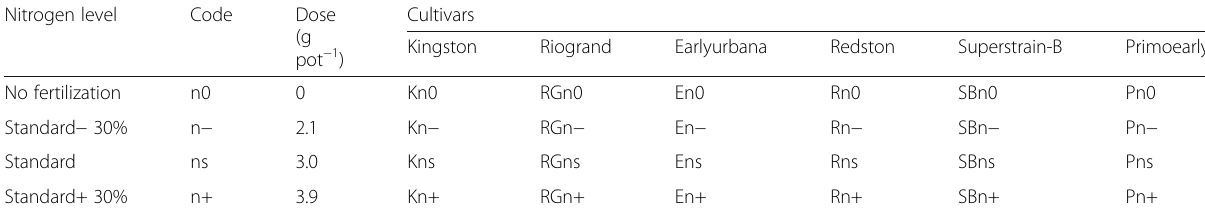
Table 2 Composition of nitrogen regimes and cultivars used in the experiments. Treatment abbreviations were presented for the ease of pronunciation and comparisons Nitrogen